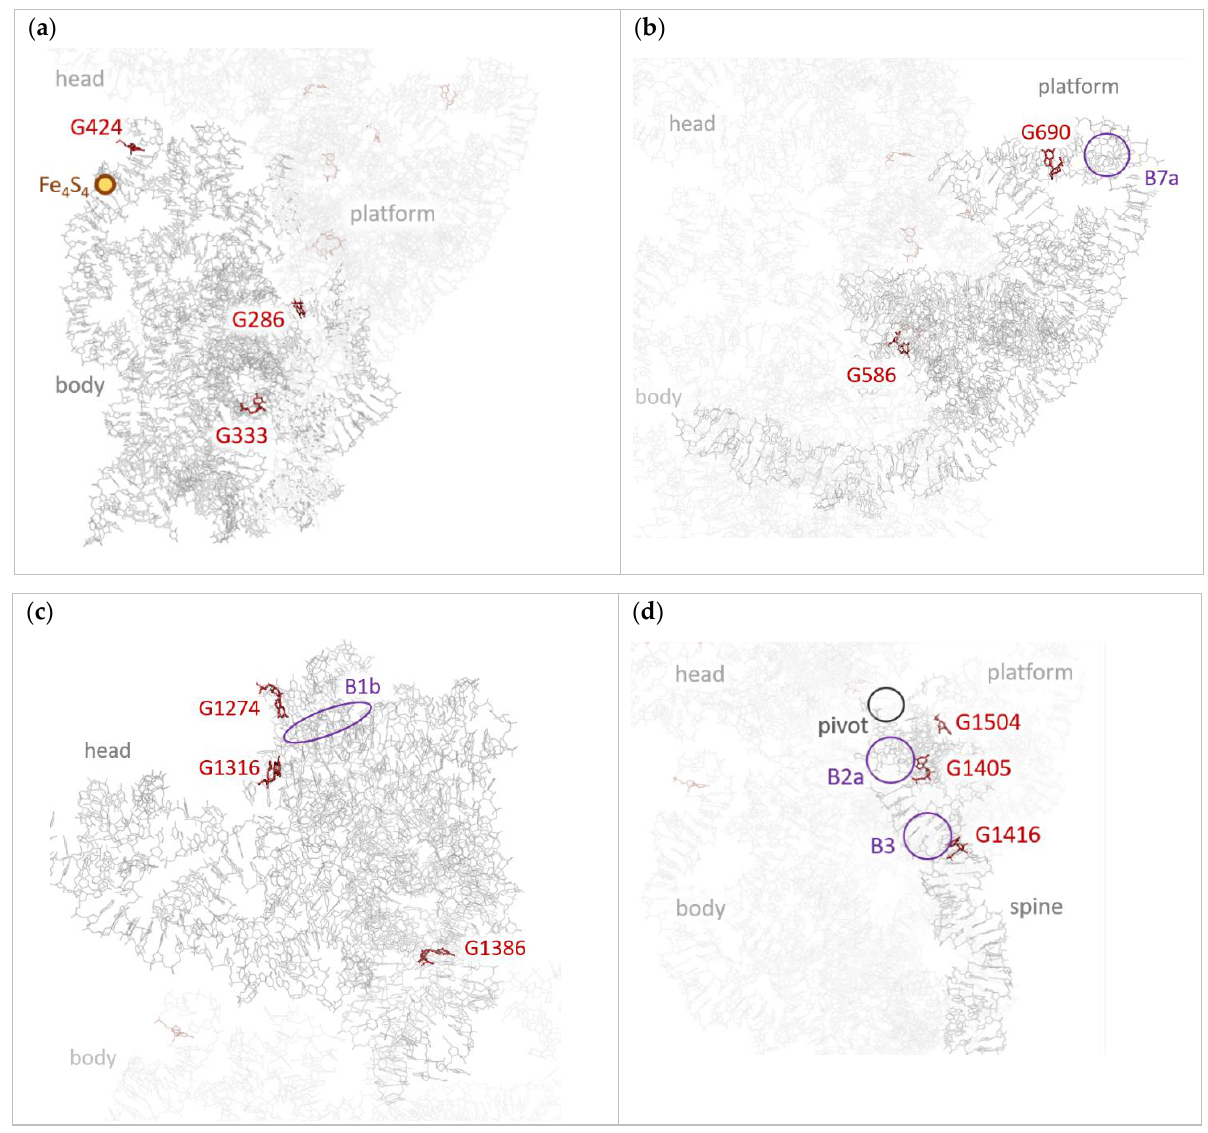
Figure 3. Hole localization sites within 5′ ( a ), central ( b ), 3′ major ( c ) and 3′ minor ( d ) domains of SSU. Functionally active areas of the ribosome near the localization sites (intersubunit bridges B1b, B2a, B3, B7a; Fe 4 S 4 cluster; pivot enabling head swiveling) are labeled.